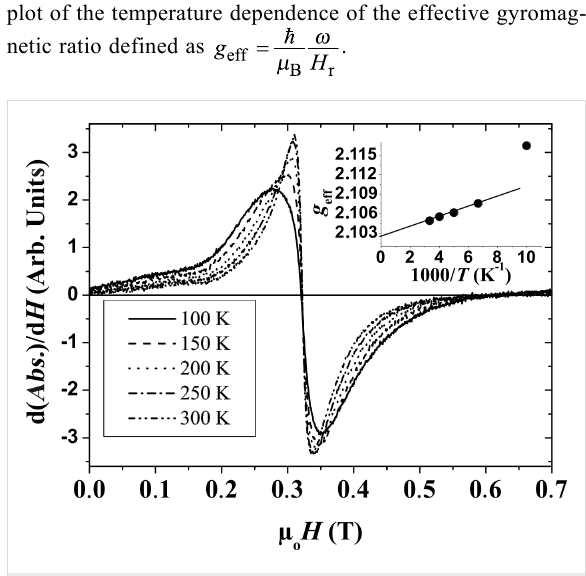
Figure 11: FMR spectra collected for various T . Inset displays the evolution of g eff versus 1/ T .